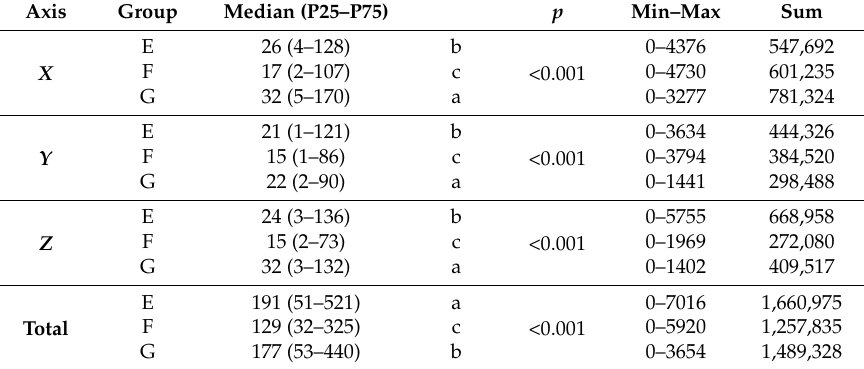
Table 3. Model 2 (with angulation). Comparison of the values of the square of the X-deviation, Y-deviation, Z-deviation, and the total in the impressions of groups E (closed tray impressions with replacement abutments), F (open tray impressions for drag copings without splinting), and G (using the 3M™ True Definition